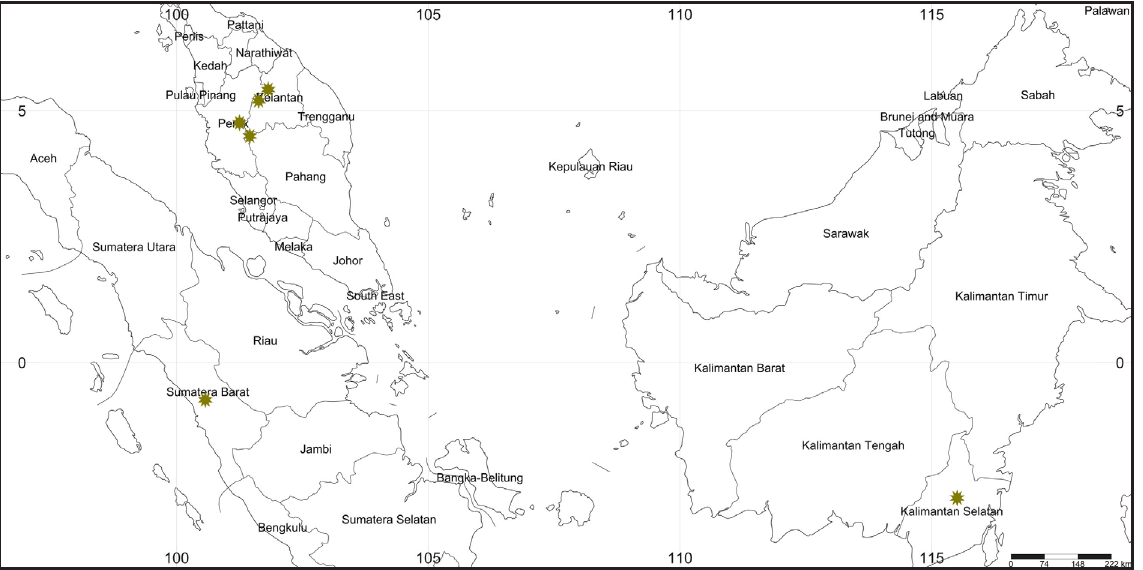
Fig. 9. Distribution map of Synchroina tenuipennis Fairmaire, 1898 from Malaysia and